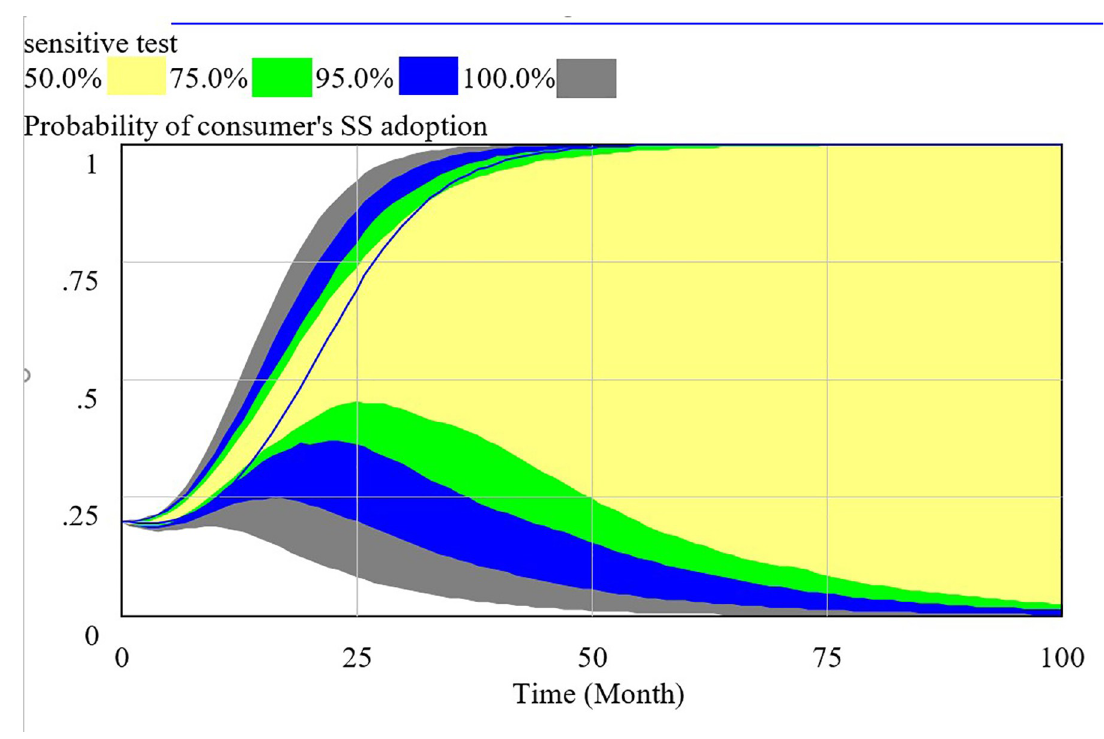
Fig 4. Sensitivity analysis of consumer’s strategy selection.